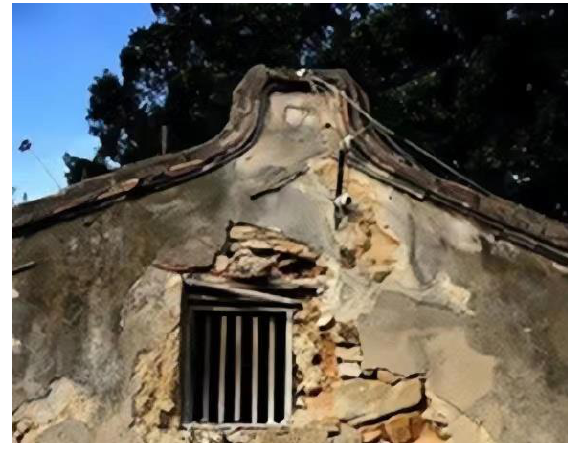
Figure 21. The “Thokakchhu” Wall.